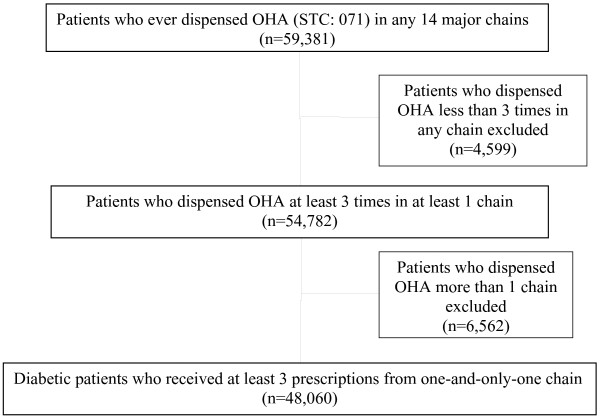
Patient selection.